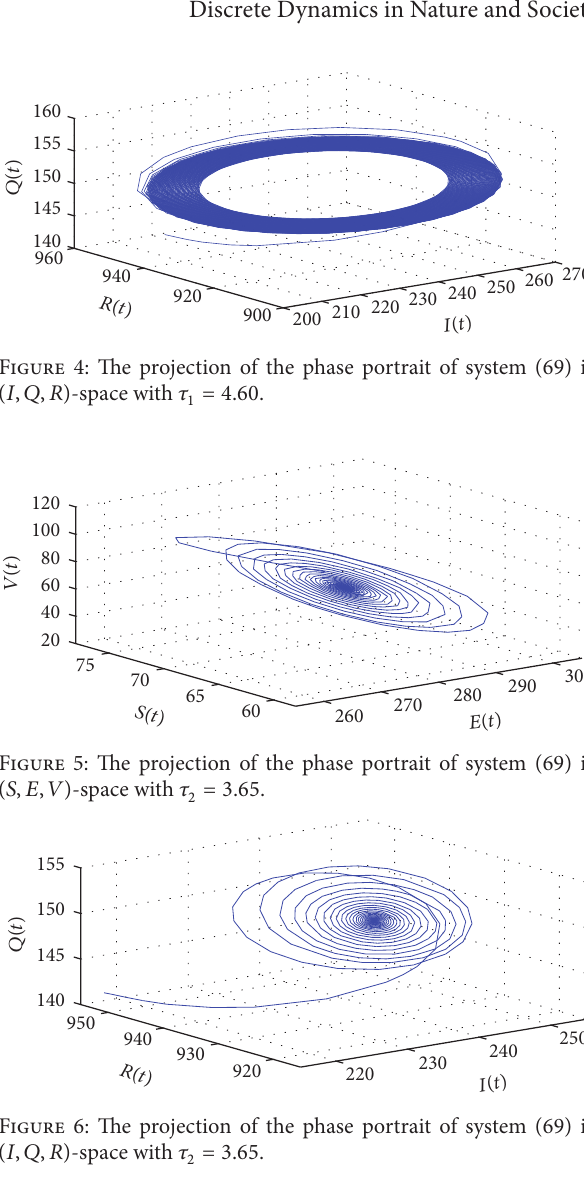
It can be easily verified that condition (𝐻 1 ) is satisfied when = 𝜏 = 0 . 𝜏 1 2